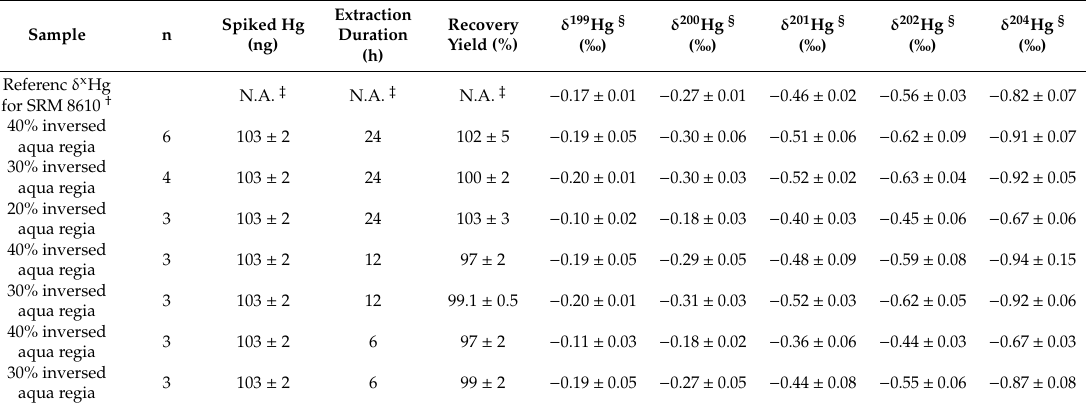
Table 2. Results (average ± standard error) of the plastic bag extraction tests using 103 ng gaseous elemental mercury prepared from SRM